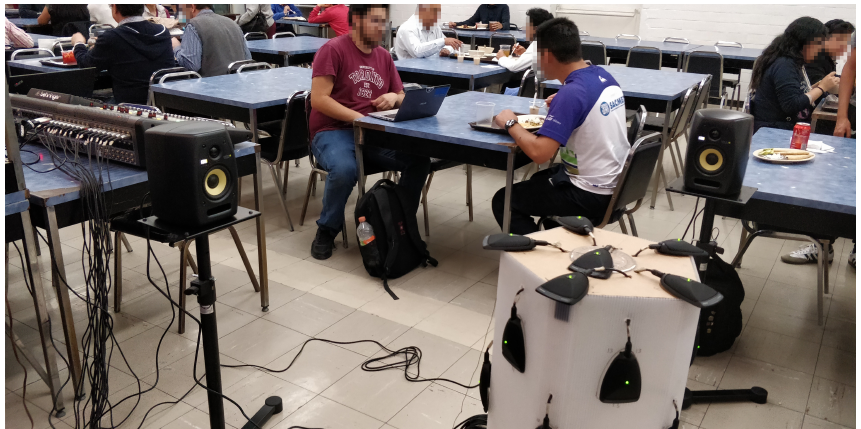
Figure 3. An example of the arrangement of the capture equipment and the position of the sound sources measurements in a real-life setting